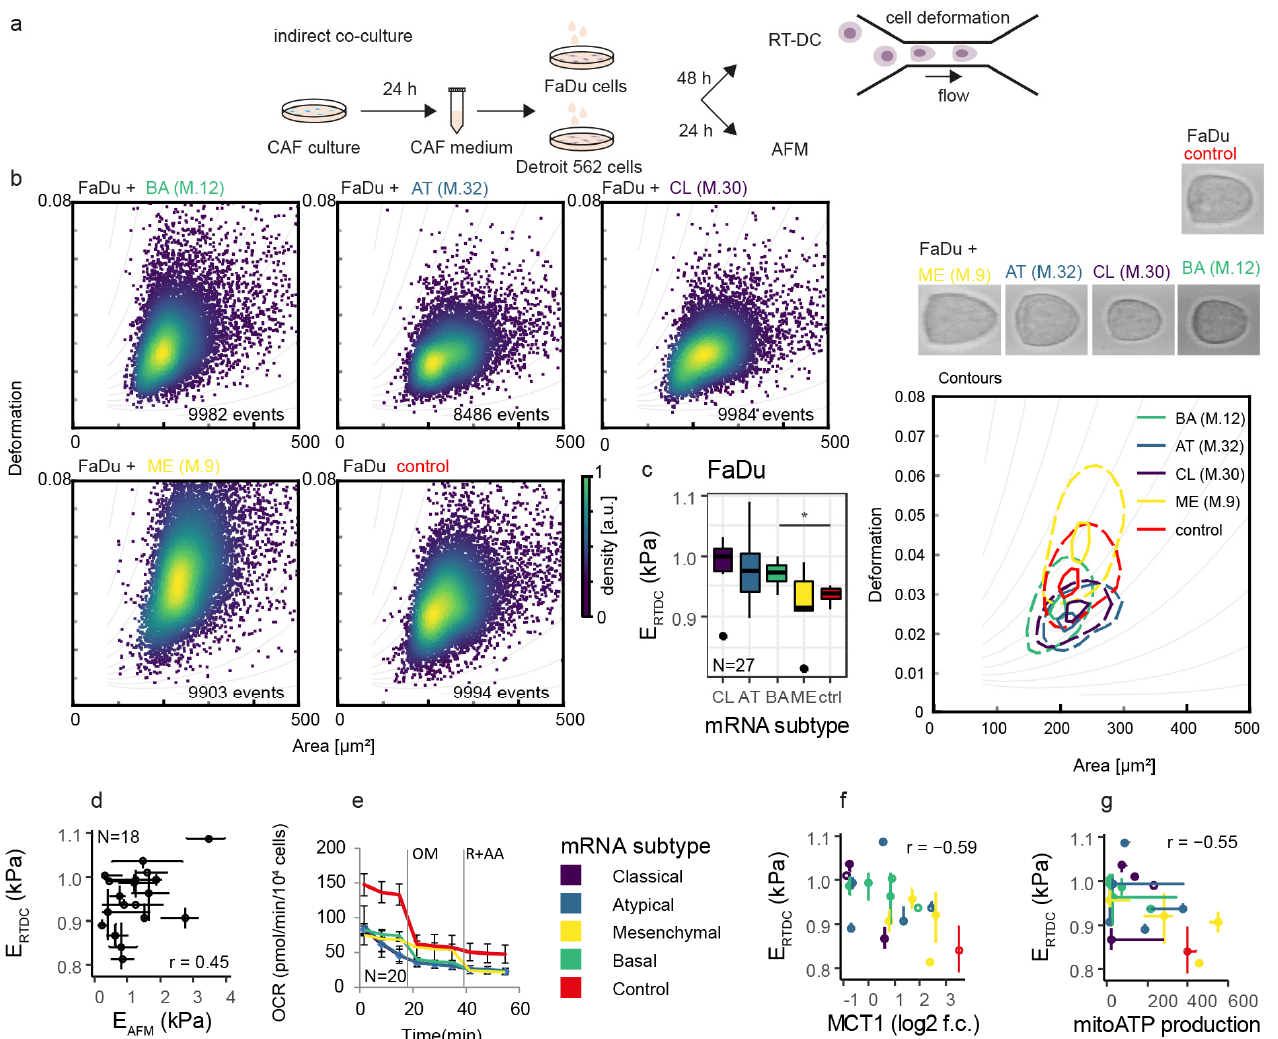
Figure 3. Cancer cell stiffness is affected by CAF coculture. ( a ) schematic of indirect (conditioned media-based) coculture experimental scheme used for cancer cell mechanophenotypisation. ( b ) Real-time deformability cytometry (RT-DC) scatterplots show the dependence of cell deformation on cell size. One dot represents a single cell. Representative scatterplots of FaDu cells cocultured with a CAF-conditioned medium (left) and contour plots of these scatterplots with representative cells (image width 25 μ m). CAFs were derived from four tumour tissue mRNA subtypes: BA, basal; AT, atypical; CL, classical; ME, mesenchymal. For all patients tested see Figure S4. ( c ) Young’s modulus determined by RT-DC (E RT-DC ) for four major mRNA subtypes. Performed in duplicates per CAF coculture treatment, N indicates the number of cocultures, asterisk indicates statistical significance at p < 0.05. ( d ) Young’s modulus determined by RT-DC and atomic force microscopy weakly correlates; for AFM measurements see Figure S4. ( e ) The oxygen consumption rate (OCR) of FaDu cells is affected by the CAF mRNA subtype and is in negative correlation with Young’s modulus ( g ), and MCT1 FaDu expression ( f ) OM = oligomycin; R = rotenone; AA = antimycin A; E RT-DC = Young modulus, real-time deformability cytometry, E AFM =Young modulus, atomic force